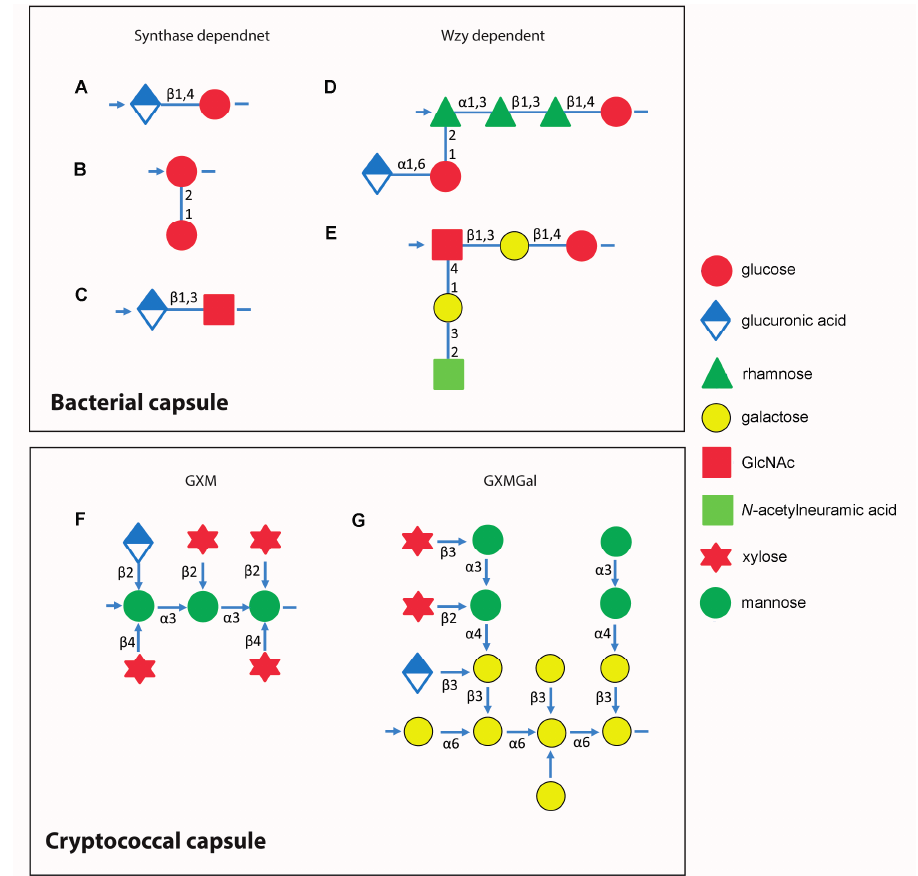
Figure 1. Capsule repeat units of Streptococcus spp. and Cryptococcus neoformans . Upper panel : capsule repeat units of Streptococcus pneumoniae serotype 3 ( A ); S. pneumoniae serotype 37 ( B ); S. pyogenes HA ( C ); S. pneumoniae serotype 2 ( D ); and S. agalactiae serotype III ( E ); Structures for additional S. pneumoniae capsules can be found in Bently et al. [18] and van Dam et al . [19]. This figure is adapted from Yother [17]. Lower panel : capsule repeat units of C. neoformans . Left, one of the six structural reporter groups that are found in varying proportions in glucuronoxylomannan (GXM) within strains of C. neoformans , defined by Cherniak et al. [20] Linkages between sugars are printed next to the arrows connecting monosaccharides ( F ); Right, the structure of glucuronoxylomannogalactan (GXMGal) ( G ). Lower panel is adapted from Doering [1]. Arrows indicate direction of polysaccharide